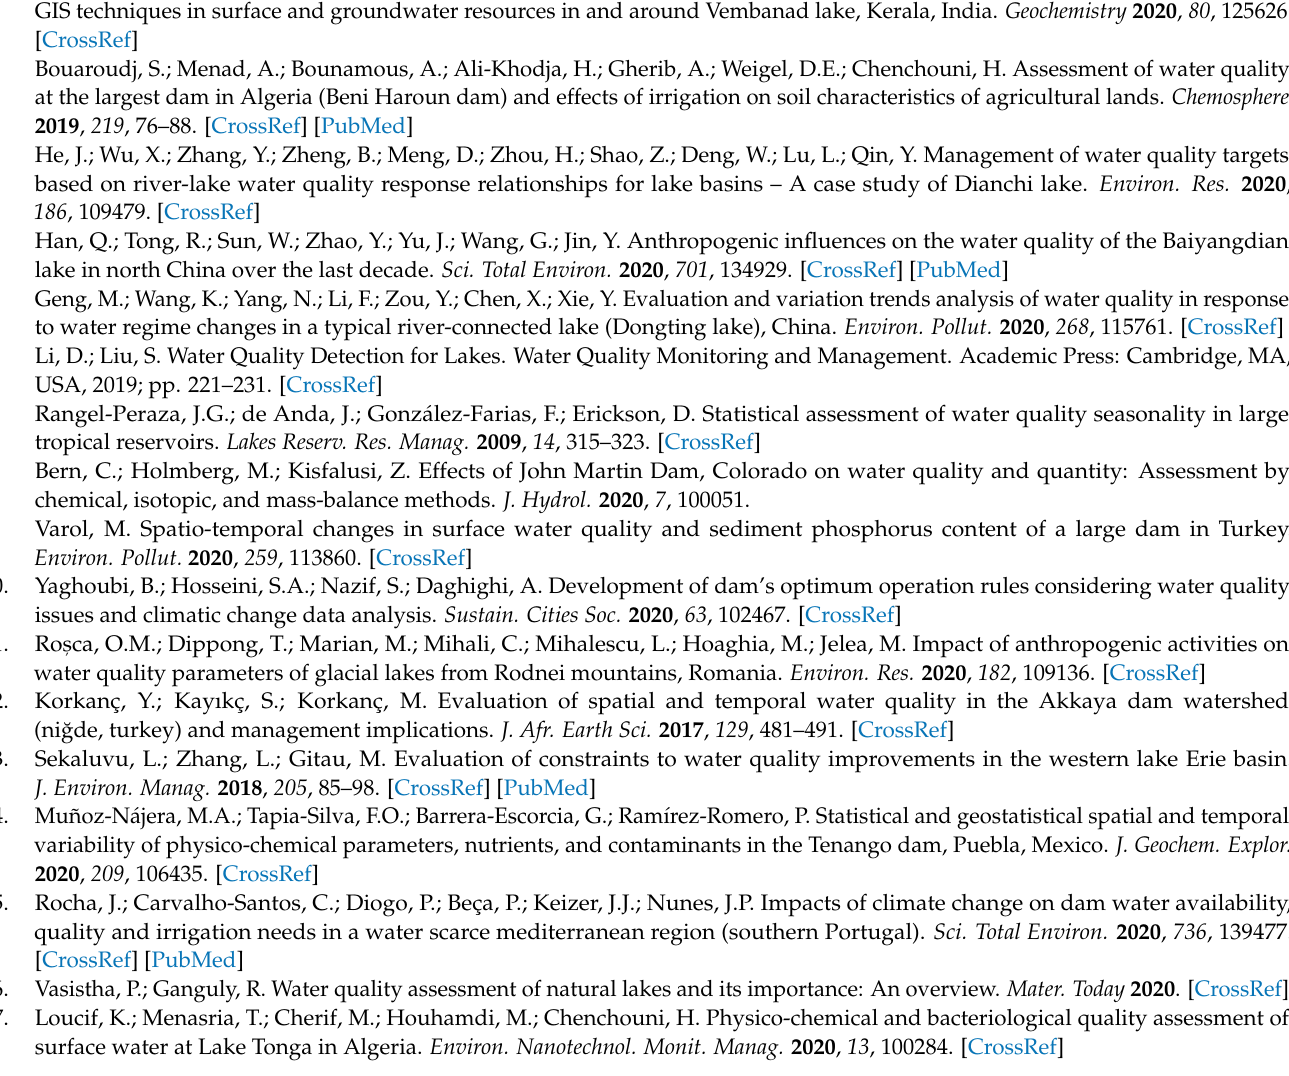
rameters; Table S1: Methodologies used to assess water quality, Table S2: Data obtained from annual samplings in the dry period, Table S3: Data obtained from annual samplings in the rainy